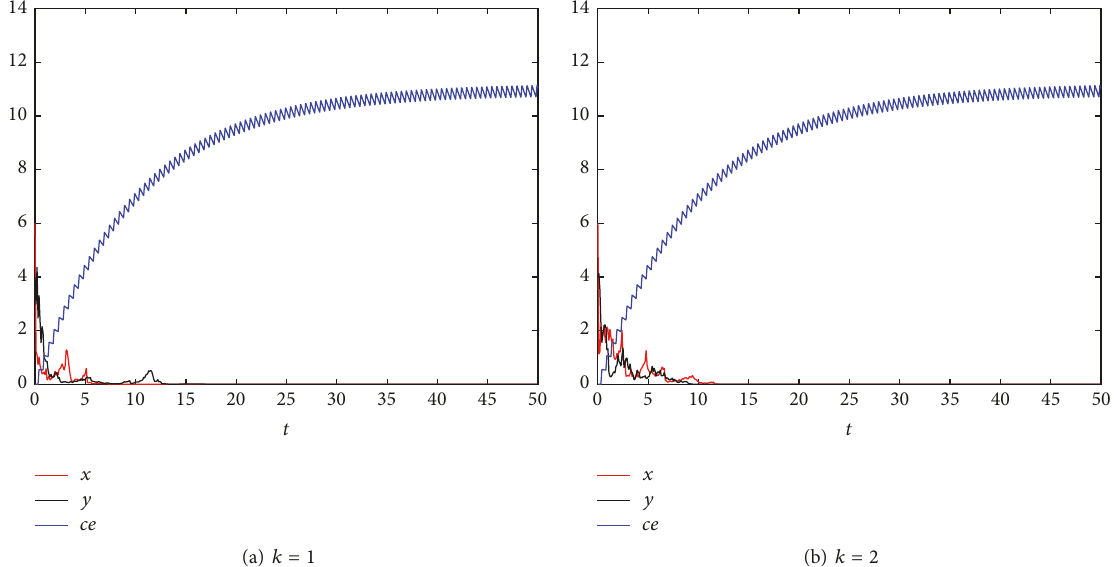
Figure 5: Sample paths of 𝑥(𝑡) , 𝑦(𝑡) with initial value 𝑥(0) = 6 and 𝑦(0) = 4 .